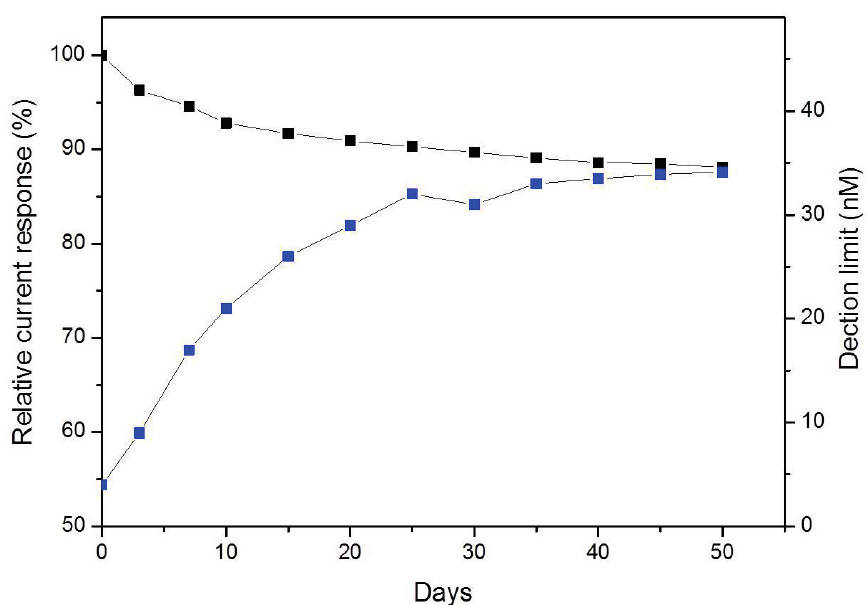
Figure 6. Stability of PPyox-CFE, expressed as percentage of sensitivity to DA in PBS (pH 7.4) and the detection limit of